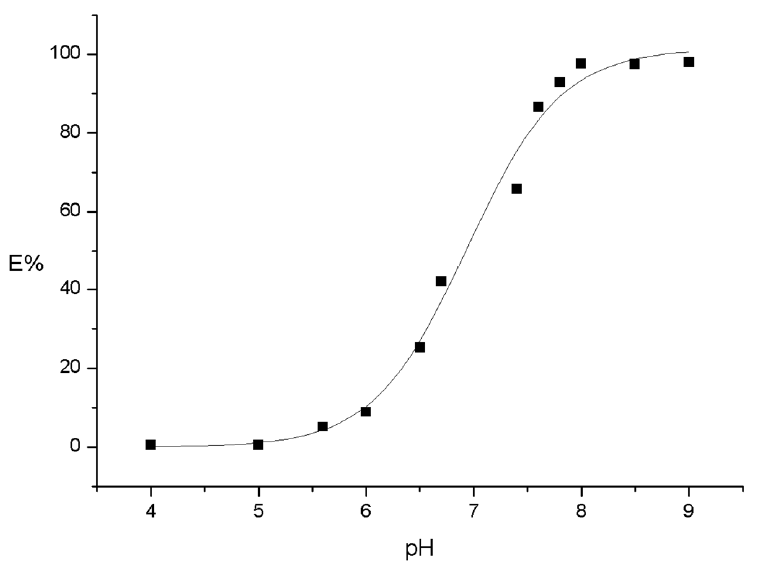
Figure 1. Percent of extraction of cadmium (II) as a function of pH in the PIM. Aqueous phase: 1 × 10 − 4 mol dm − 3 , PIM: 23.4% CTA, 54.5% NPOE, and 21.1% Kelex 100 ( w / w ).